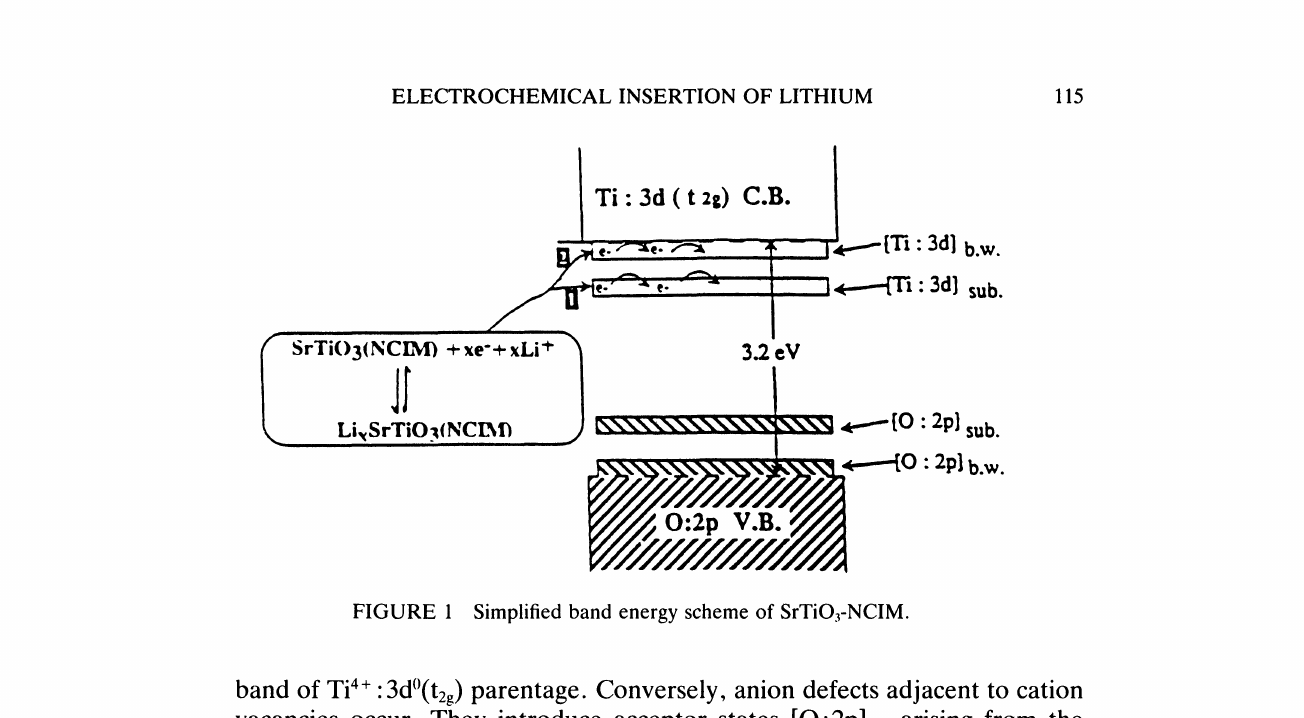
FIGURE Simplified band energy scheme of SrTiO3-NCIM.